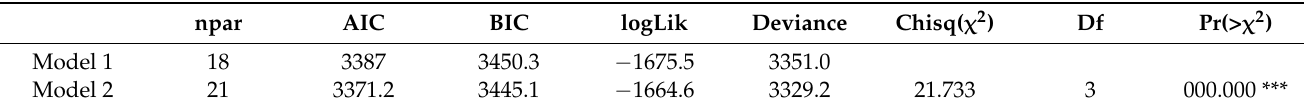
Table 7. Likelihood ration test